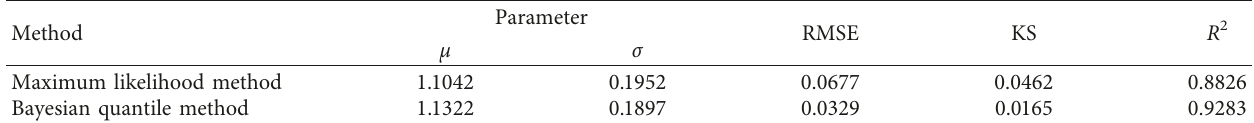
Table 2: Parameter estimates, RMSE, KS, and R 2 for the drilled pile foundation.